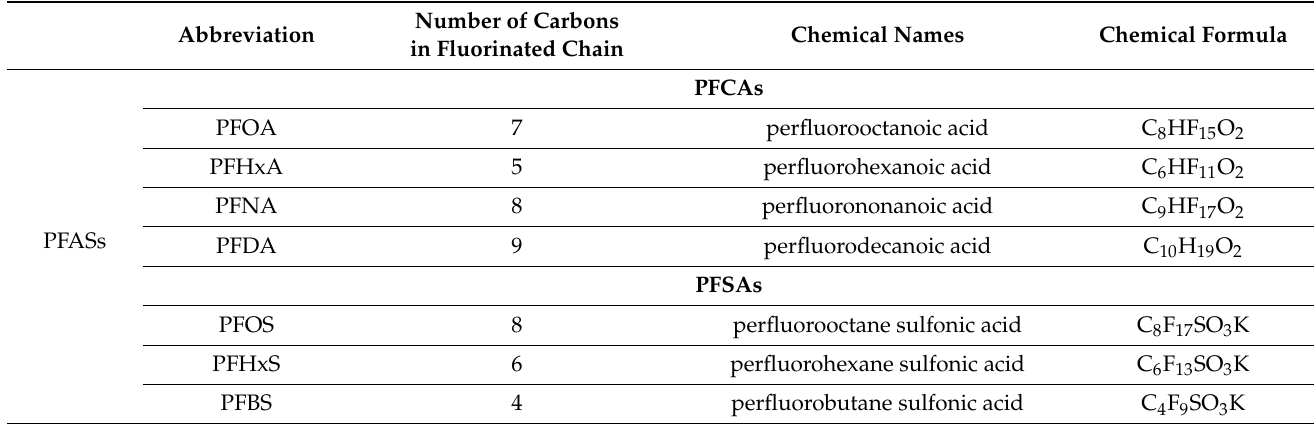
Table 1. The chemical structure of per- and polyfluoroalkyl substances (PFASs) most often used in the